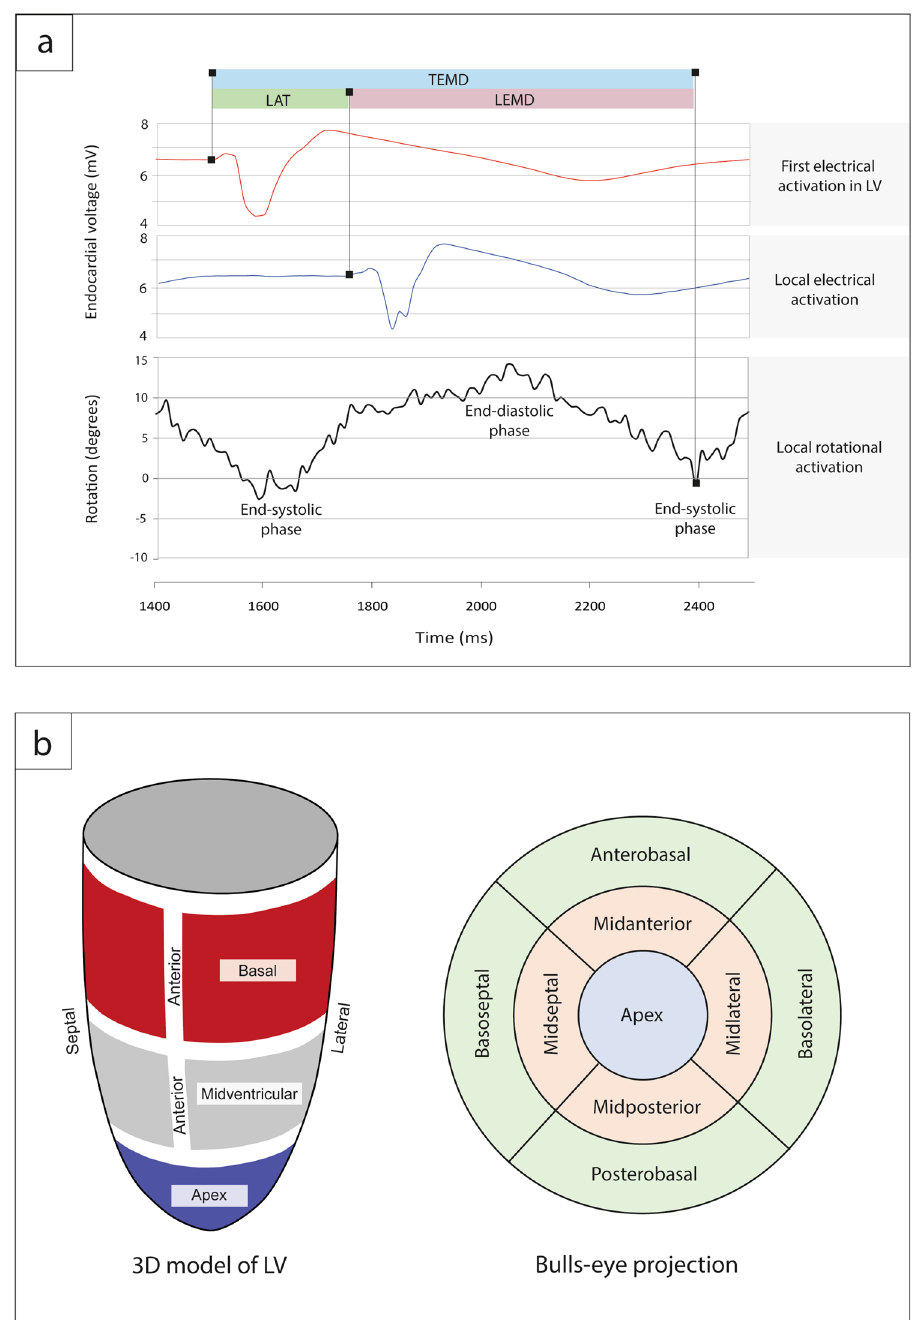
Figure 1. ( a ) Analyzed electro-mechanical parameters. ( b ) Standardized 9-segment bulls-eye projection in NOGA XP